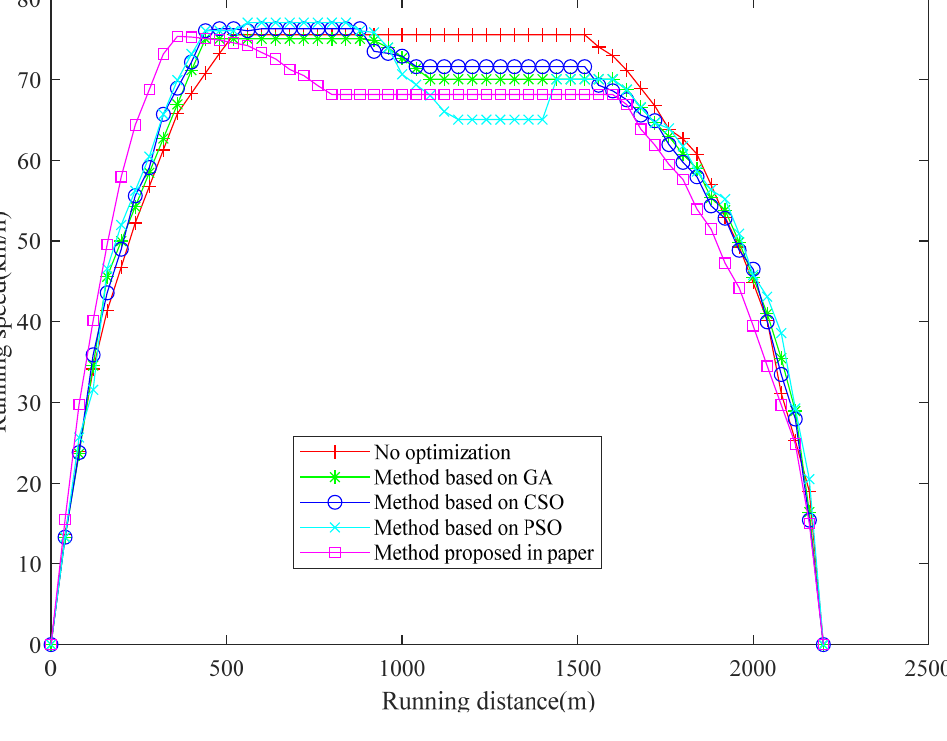
Figure 4. Running distance and running acceleration.